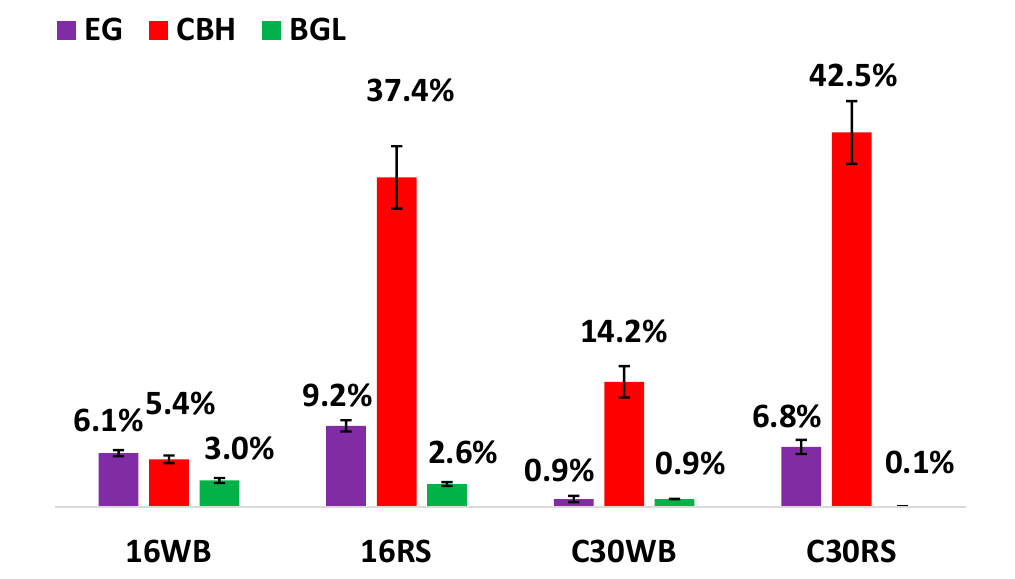
Figure 3. Percentage of EG, CBH, and BGL. Table 3. The up-regulated and down-regulated proteins of 16WB compared with